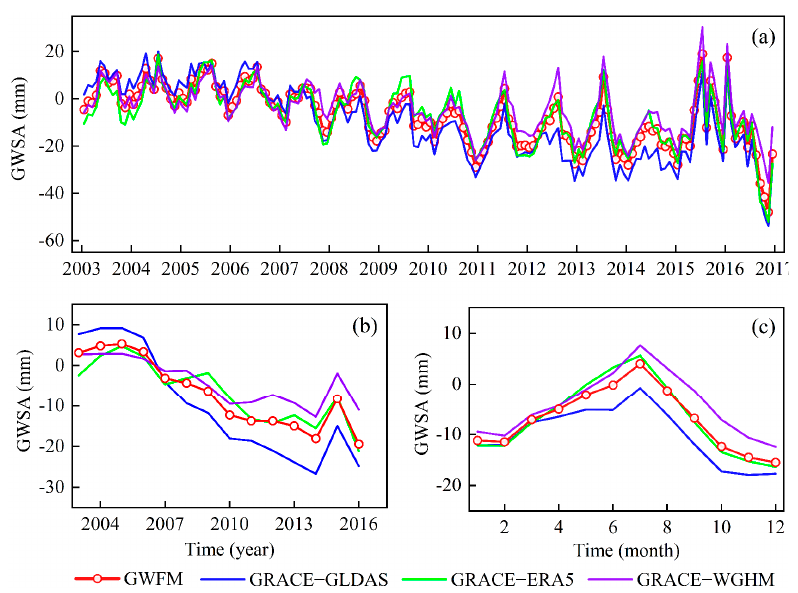
Figure 6. Comparison of GRACE-based and GWFM-based GWSA on different time scales over the HC during the period from 2003 to 2016. ( a ) Monthly; ( b ) annual; ( c ) seasonal. From the perspective of the long-term trend, GWSA reveals a significant downward trend over the study period. Notably, 2011 is a turning point, and the downward trend before 2011 is significantly higher than the trend after 2011. In order to clarify the difference between the four results, multivariate statistical analysis is used for the GWSA time series in the two time periods of 2003–2010 and 2011–2016 in the HC. Table 3 summarizes the evaluation indexes for the GWSA time series, including the long-term trend and annual amplitude. From 2003 to 2010, four GWSA downtrends range from 1.08 (GRACE − ERA5) to 4.17 (GRACE − GLDAS) mm/yr, which clearly indicates groundwater depletion in the HC during the period from 2003 to 2011. From 2011 to 2016, the results also show a downward trend (except GRACE − WGHM), and decline rates range from 0.46 (GWFM) to 0.70 (GRACE − ERA5) mm/yr, while GRACE − WGHM increased at a rate of 0.07 mm/yr. The rate of decline from 2011 to 2016 is significantly slower than that from 2003 to 2010, while the annual amplitude, compared with the previous period, increases significantly. This result may be related to the water policy in the area, such as Gansu Province gradually implementing the most stringent water-resource management system and measures of “points to areas, Hexi first” in 2011 [67]. Table 3. Comparison of annual amplitude and trend between GWSA from GRACE − GLDAS, GRACE − ERA5, GRACE − WGHM, and GWFM. Datasets